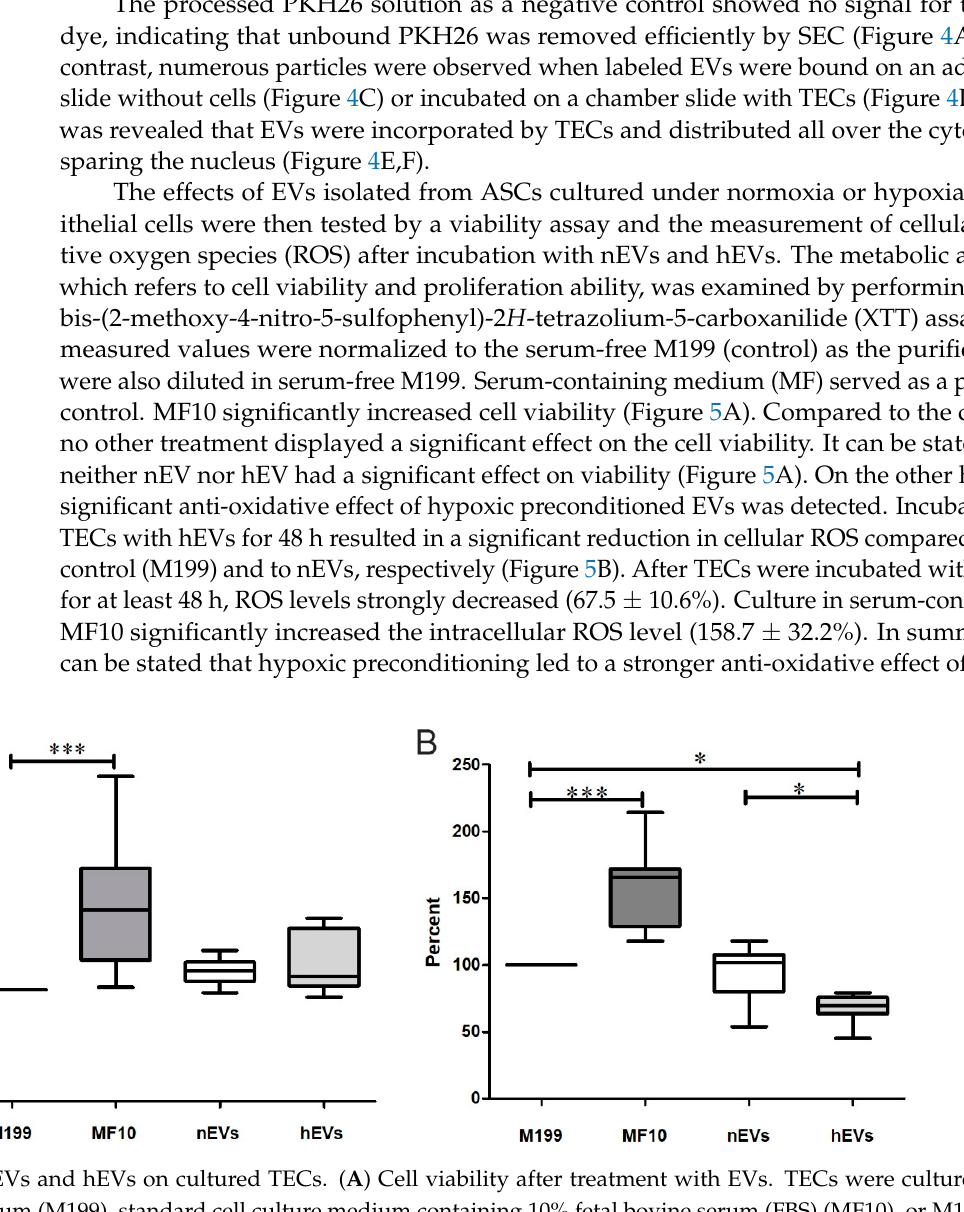
Figure 4. PKH26 staining of EVs and incorporation into cultured tubular epithelial cells (TECs). Fluorescence microscopy showed that TECs (nuclei stained with 4 ′ ,6-diamidin-2-phenylindol (DAPI)) uptake PKH26-labeled EVs (red). ( A , B ) Neg- ative control. TECs incubated with a processed PKH26 solution without EVs (( A ) nuclei staining, ( B ) red fluorescence channel). ( C ) PKH26-labeled EVs on an adhesion slide. ( D – F ) TECs incubated with PKH26-stained EVs clearly showing incorporation of labeled EVs into the cytosol of TECs (( D ) nuclei staining, ( E ) red fluorescence channel, ( F ) overlay of D and E ). Scale bar = 10 µm.